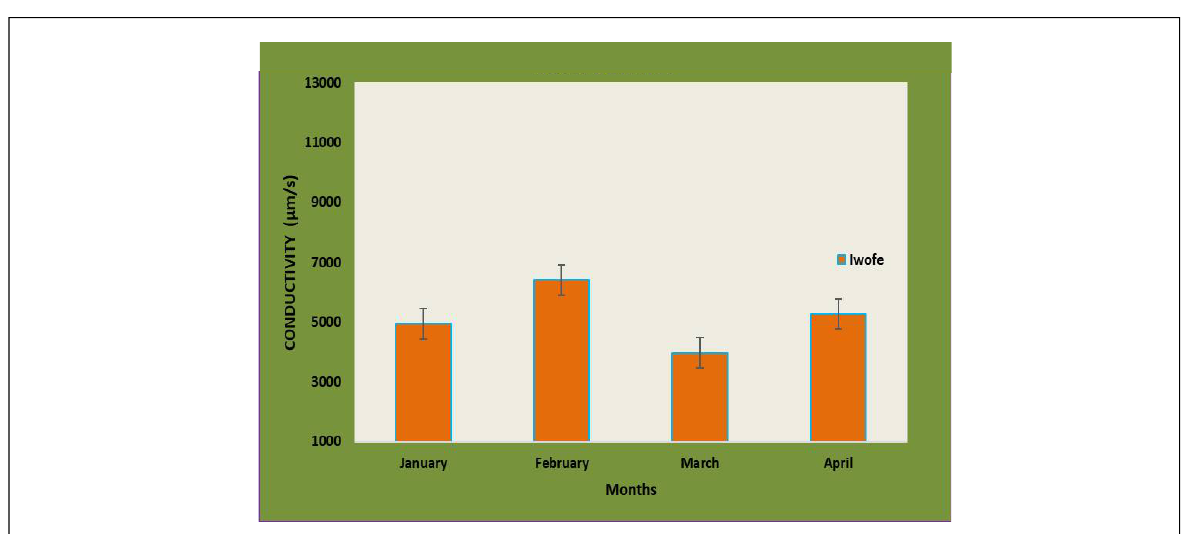
Figure 6: Conductivity of Iwofe